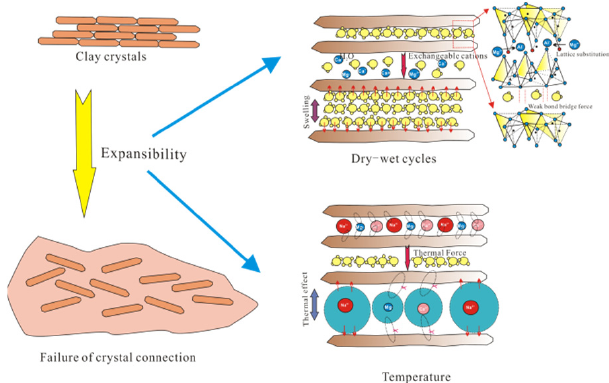
Figure 14. Failure mechanism of CMS subjected to dry–wet cycling and temperature.